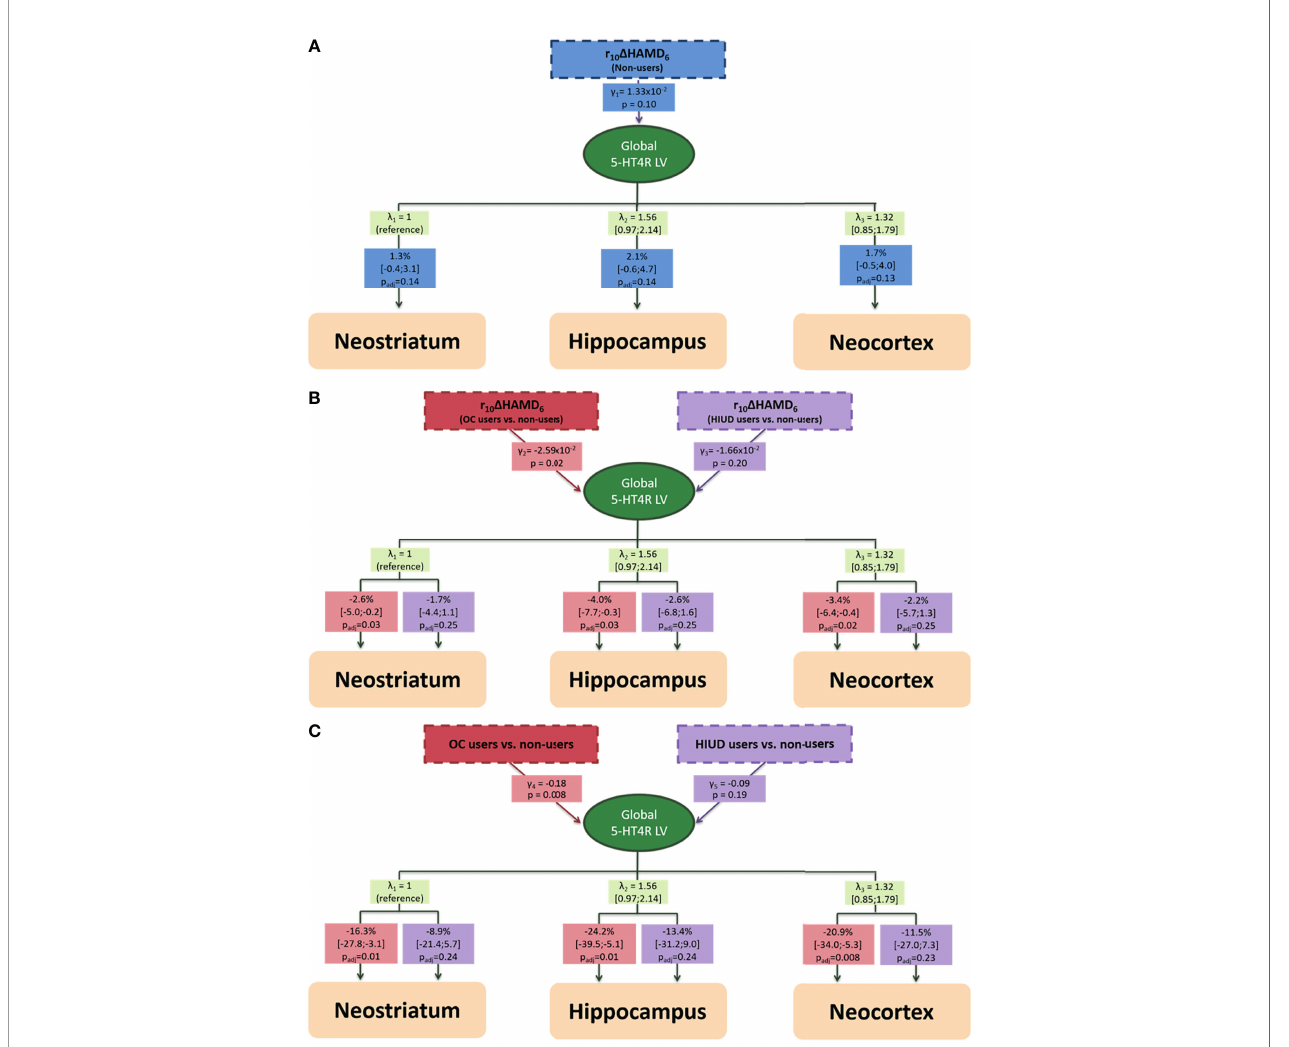
FIGURE 4 | The estimated latent variable model for the association between baseline 5-HT4R binding and week eight antidepressant treatment response as a function of hormonal contraceptive status shown in three layers (A – C) . (A) The association between baseline 5-HT4R binding and treatment response in non-users. (B) The difference in the association between baseline 5-HT4R binding and treatment response between the non-users and the oral contraceptive (OC) and the hormonal intrauterine device (HIUD) users, respectively. (C) The estimated effect of OC and HIUD use on 5-HT4R binding when no change in Hamilton Depression Rating Scale 6 items (HAMD6). g is the estimates of the association with the global latent variable interpreted as global (log-transformed) 5-HT4R BP ND estimates. l is the loading on each region. The boxes beneath the loadings indicate the percentage difference in 5-HT4R binding for each brain region. Regional bindings were adjusted for Age, BMI, 5-HTTLPR genotype and injected tracer mass per kg bodyweight (not shown). P-values and con fi dence intervals are adjusted for 3 comparisons. r 10 D HAMD 6 : 10% relative change in Hamilton Depression Rating Scale 6